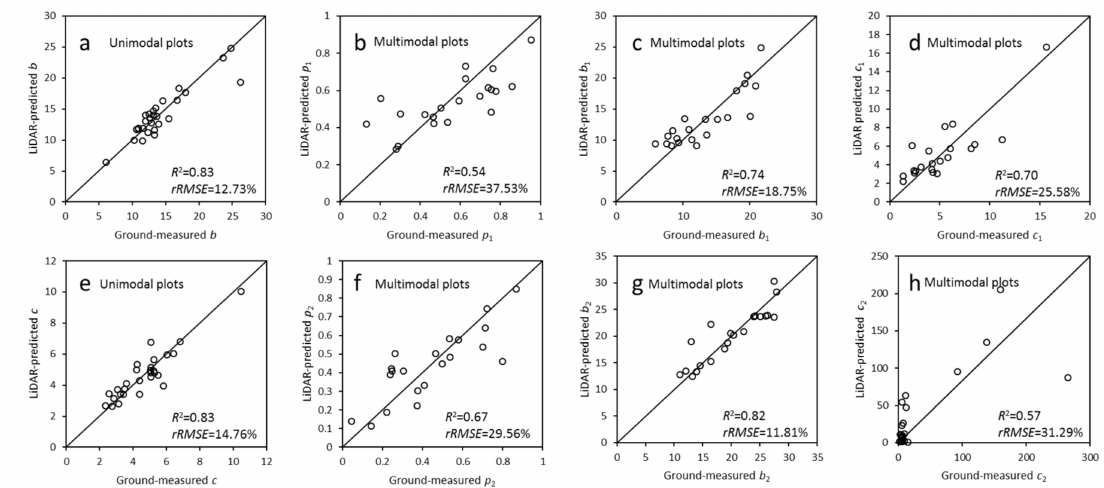
Figure 4. Scatter plot of cross-validations for the ground-measured UWM parameters and finite mixture model (FMM) parameters vs. the LiDAR-predicted UWM parameters and FMM parameters in differentiated unimodal plots and multimodal plots. ( a , e ) scale and shape of UWM of differentiated unimodal plots; ( b , f ) proportion of differentiated multimodal plots; ( c , g ) scale parameters of FMM of differentiated multimodal plots; ( d , h ) shape parameters of FMM of differentiated multimodal